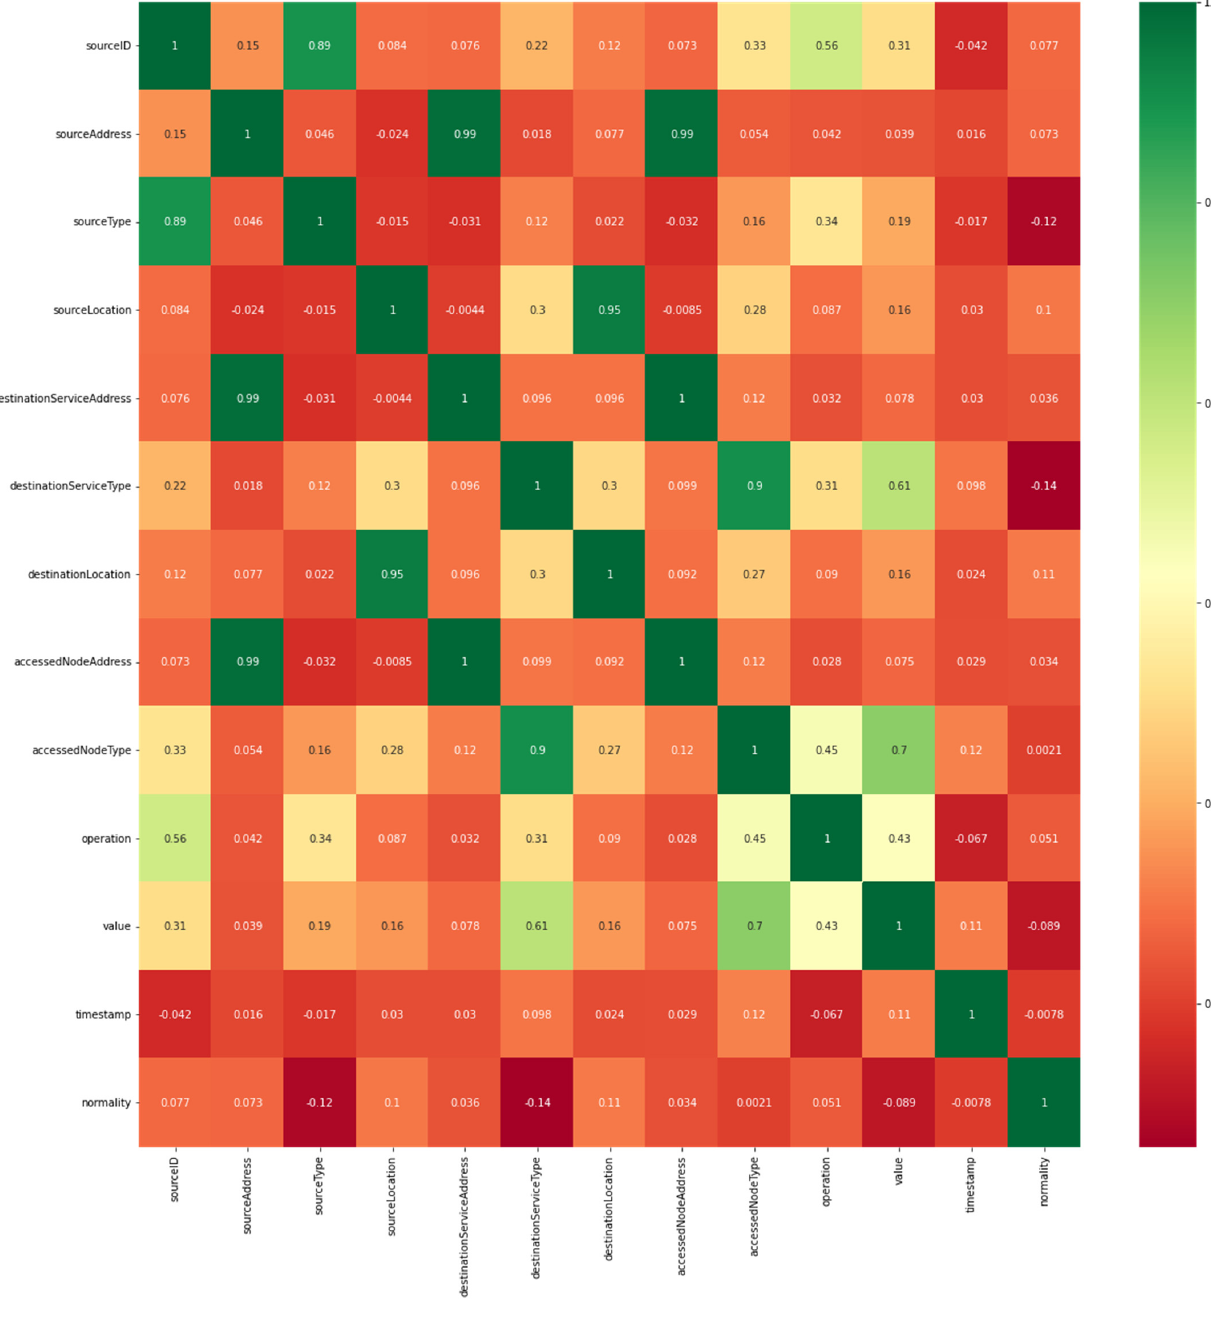
Figure 10. Top 5 features that has a strong relationship with the target variable.